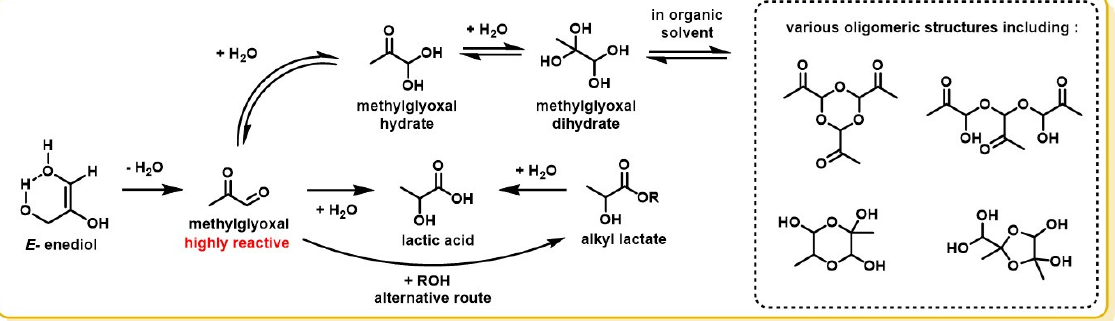
Figure 13. MGO hydrates and lactic acid conversion from the enediol intermediate of DHA–Gld interconversion.